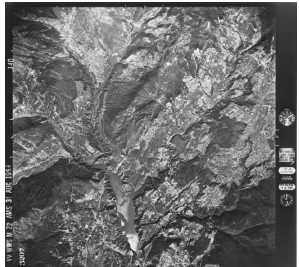
Figure 2. Halftones example from the 1992 MPLFT map.